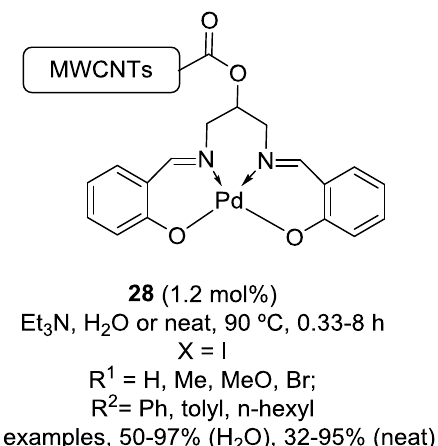
Figure 10. Palladium species on functionalized multi-walled carbon nanotubes as catalysts for the Sonogashira reaction. Conditions, substrate scope and yield range (Scheme 2).